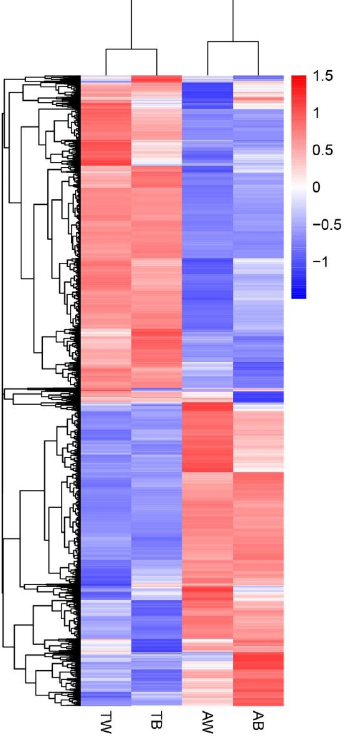
Figure 5. Cluster heat map of differentially expressed genes. The abscissa is the sample name, and the ordinate is the normalized value of the differential gene FPKM. The darker the red, the higher the expression level, and the darker the blue, the lower the expression level.